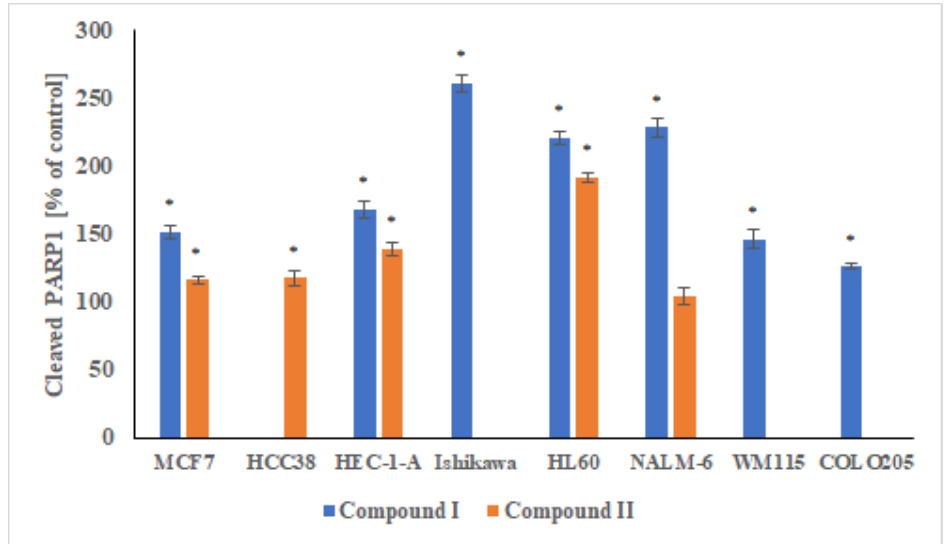
Figure 11. Measurement of PARP1 degradation in MCF7, HCC38, HEC-1-A, Ishikawa, COLO205, HL60, NALM-6, and WM115 cells exposed to compound I and II . Cells were incubated with deriva- tives for 24 h at concentrations of the calculated IC 50 . The results represent mean ± SEM of the data from 3 individual experiments, untreated control cells arbitrarily taken as 100%, * p < 0.05 vs. control.